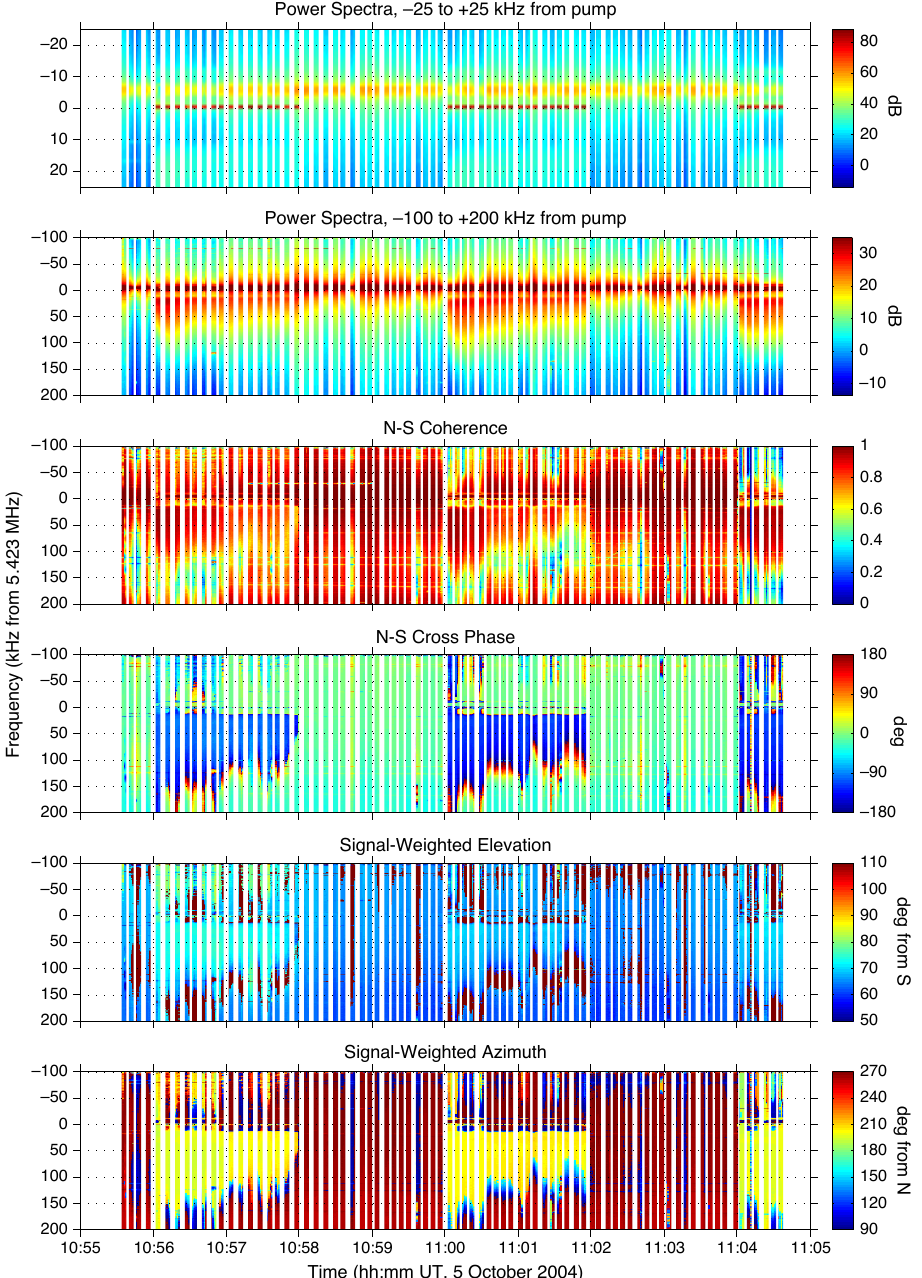
Isham et al. Figure 12 Fig. 12. SEE interferometer data from 5 October 2004 at EISCAT on Ramfjordmoen. The top panel shows the power spectrum of the central antenna on a ± 25kHz frequency scale. The pump can be clearly seen cycling 2-min on, 2-min off; the strong feature at about 6kHz is interference. Due to the high levels of the pump and the interference, no SEE features can be seen in this panel. The second panel shows the SEE power spectrum from − 100 to + 200kHz on a more limited intensity scale. The BUM 1 can be clearly seen, but the DM, which is present, is obscured by the interfering signal. Panels three and four show the coherence and cross phase along the north-south path, and the bottom two panels show the elevation and azimuth angles computed from the cross phase of the north-south and east-west antenna pairs. Azimuth is measured from geographic north and ranges from 90 (due east) through 180 (geographic south) to 270 (due west), while elevation ranges from 0 (on the southern horizon) through 90 (vertical) to 180 (on the northern horizon), although only elevations from 50 to 110 are plotted. These scales were chosen in order to show any signals from north of vertical on a continuous scale with signals from the south. The data were recorded in 4-s-long files, with a 2- to 4-s data gap between files. The time and frequency resolutions in this figure are 1s and 1kHz,